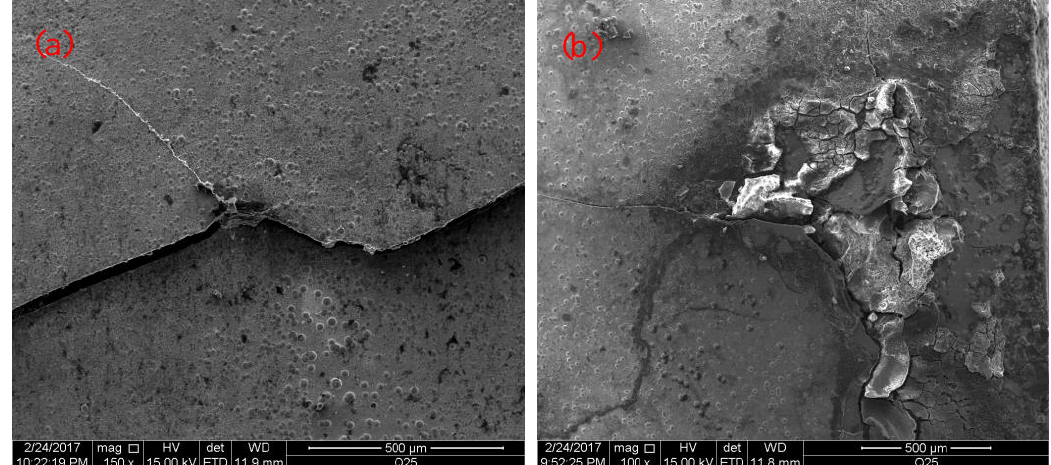
Figure 6. SEM images of unannealed NPC after immersion test showing ( a ) cracks, and ( b ) etch pits. Evolution of surface morphologies of the annealed NPC/Phosphate during immersion test are